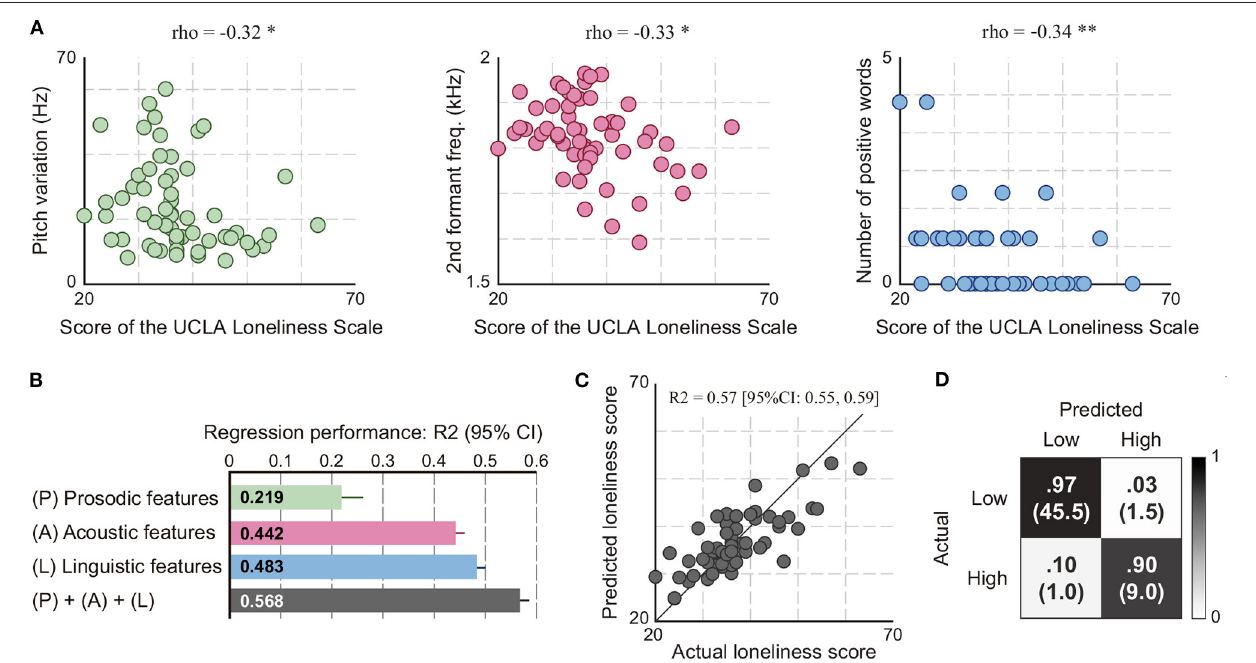
FIGURE 4 | Analysis results of the associations of speech responses to eight daily life questions with scores of the UCLA Loneliness Scale. (A) Examples of speech features correlated with loneliness scores (Spearman correlation; * P < 0.05 and ** P < 0.01). (B) Regression performances of the models using speech features for estimating loneliness scores. (C) Actual and predicted loneliness scores by the regression model using acoustic, prosodic, and linguistic features. (D) Confusion matrix of the binary-classification model using acoustic, prosodic, and linguistic features for detecting individuals with high loneliness scores. It was obtained using 20 iterations of 10-fold cross-validation. The number in parentheses indicates the mean number of participants among 20